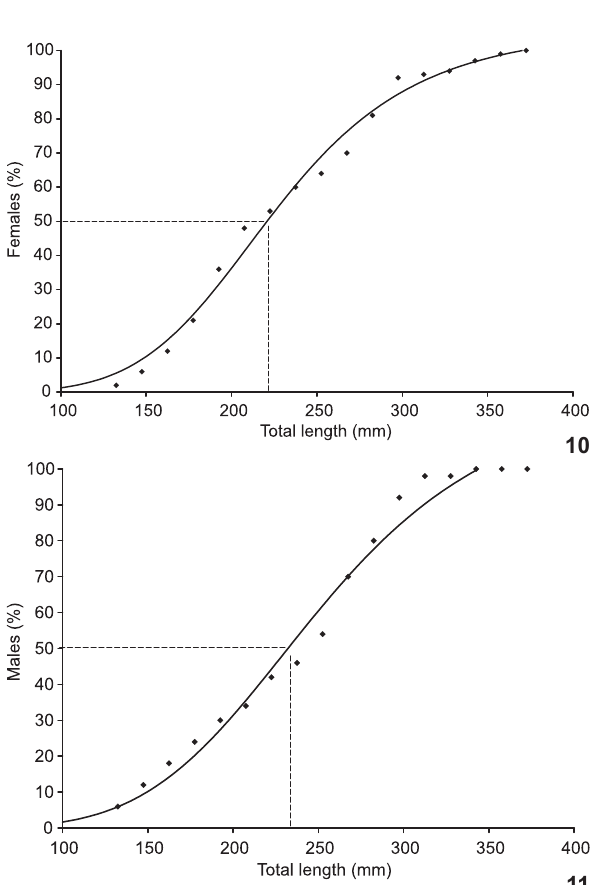
Figures 10-11. Mean length at first maturity (L females n = 123 (10) and males n = 105 (11) in Paraíba do Norte River Estuary,